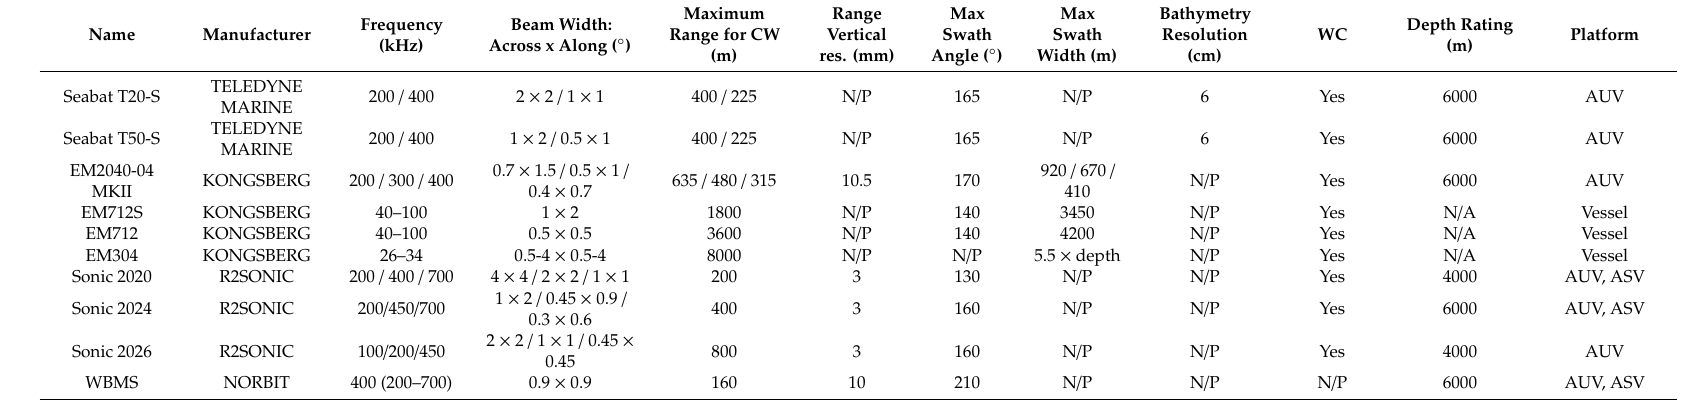
Table 6. Acoustic sensor: multi-beam echo-sounder (MBES), WC = water